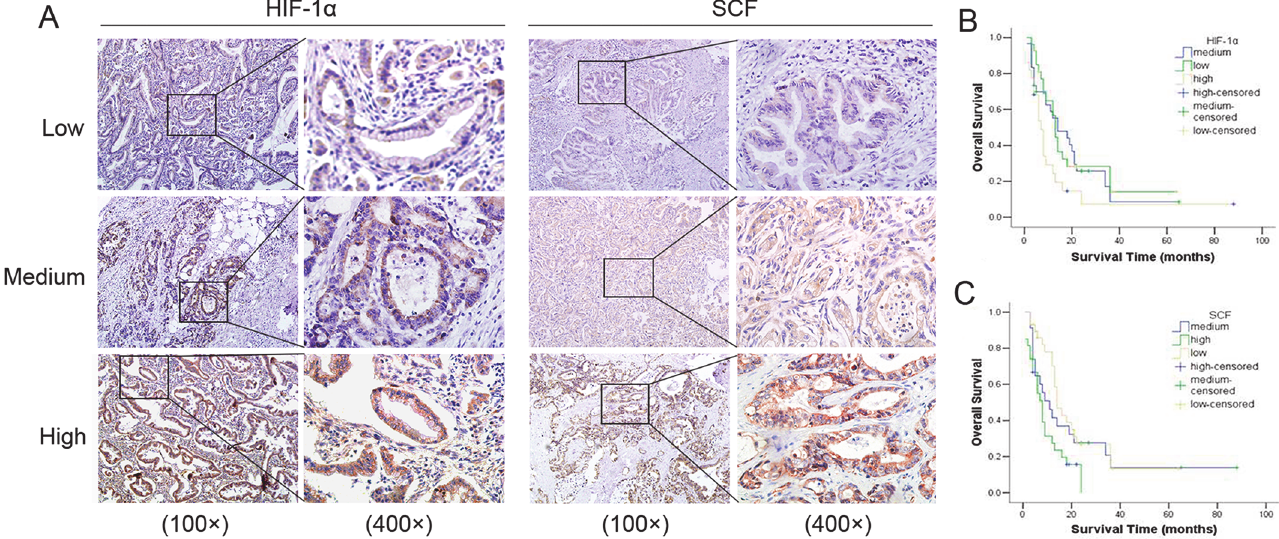
Fig 1. HIF-1 α and SCF expression in pancreatic adenocarcinoma tissue and the cumulative survival analysis. (A): The IHC results of HIF-l α and SCF. SCF protein expression was significantly correlated with HIF-l α , as detected by immunohistochemical staining on PDAC. Left panels: various expression levels of HIF-l α protein. Right panels: expression of SCF protein of the same samples in the adjacent section. (B): The results of survival analysis on HIF-l α . PDAC patients (n = 95) with high positive HIF-l α protein expression had significantly worse total survival than those with low or medium positive expression. (C): The results of survival analysis on SCF. The same PDAC patients (n = 95) with high positive SCF protein expression had significantly worse total survival than those with low or medium positive expression.